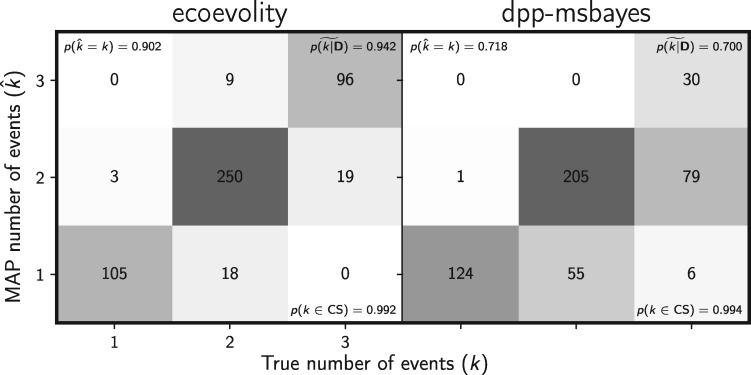
Comparing the ability to estimate the number of divergence events between (left) the new full-likelihood Bayesian method, ecoevolity, and (right) the approximate-likelihood Bayesian method, dpp-msbayes. Each plot shows the results of the analyses of 500 simulated data sets; the number of data sets that fall within each possible cell of true versus estimated numbers of events is shown, and cells with more data sets are shaded darker. Each simulated data set contained three pairs of populations, and the simulated character matrix for each pair consisted of 200 loci, each with 200 linked sites (40,000 characters total). The estimates are based on the number of events with the maximum a posteriori (MAP) probability. For each plot, the proportion of data sets for which the number of events with the largest posterior probability matched the true number of events—\documentclass[12pt]{minimal}
\usepackage{amsmath}
\usepackage{wasysym}
\usepackage{amsfonts}
\usepackage{amssymb}
\usepackage{amsbsy}
\usepackage{upgreek}
\usepackage{mathrsfs}
\setlength{\oddsidemargin}{-69pt}
\begin{document}
}{}$p(\hat{{k}} = {k})$\end{document}—is shown in the upper left corner, the median posterior probability of the correct number of events across all data sets—\documentclass[12pt]{minimal}
\usepackage{amsmath}
\usepackage{wasysym}
\usepackage{amsfonts}
\usepackage{amssymb}
\usepackage{amsbsy}
\usepackage{upgreek}
\usepackage{mathrsfs}
\setlength{\oddsidemargin}{-69pt}
\begin{document}
}{}$\widetilde{p({k}|{\mathbf{D}})}$\end{document}—is shown in the upper right corner, and the proportion of data sets for which the true number of events was included in the 95% credible set—\documentclass[12pt]{minimal}
\usepackage{amsmath}
\usepackage{wasysym}
\usepackage{amsfonts}
\usepackage{amssymb}
\usepackage{amsbsy}
\usepackage{upgreek}
\usepackage{mathrsfs}
\setlength{\oddsidemargin}{-69pt}
\begin{document}
}{}$p({k} \in \textrm{CS})$\end{document}—is shown in the lower right. We generated the plot using matplotlib Version 2.0.0 (Hunter 2007)